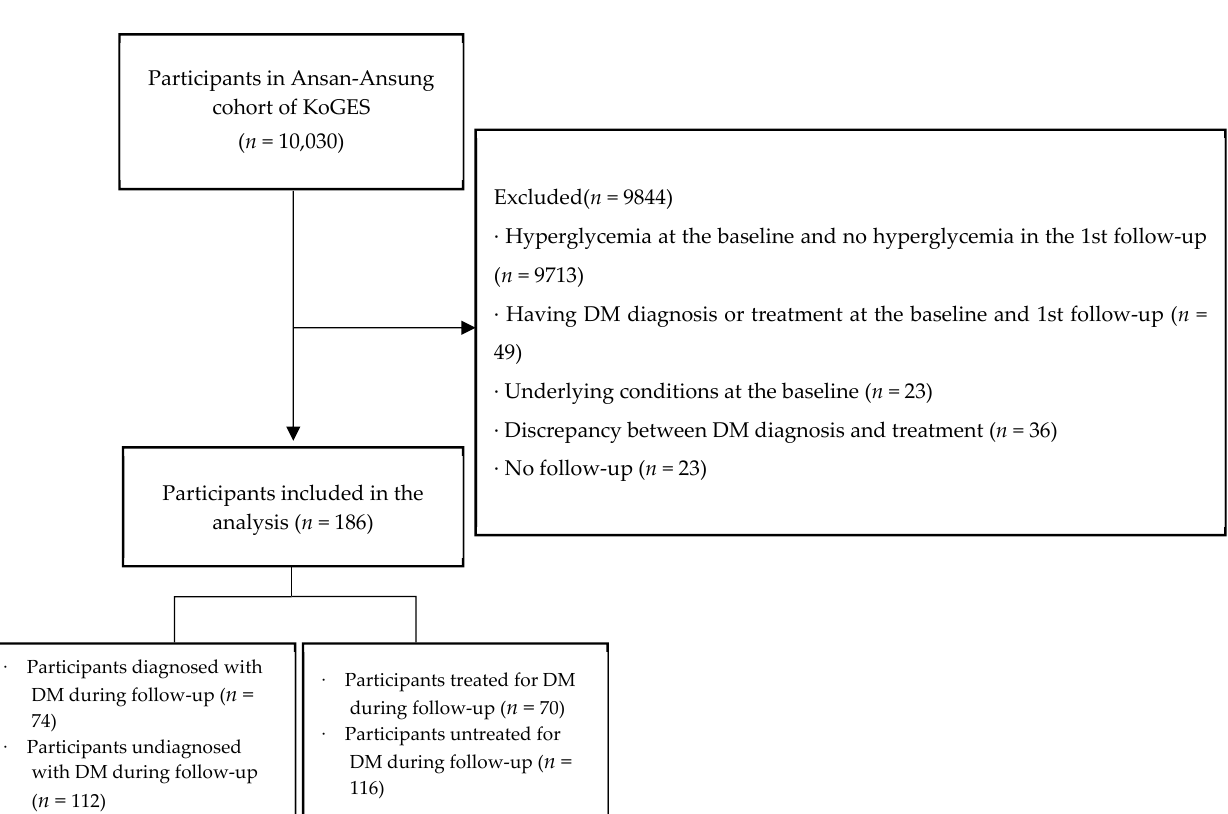
Figure 1. Flowchart of study participants’ selection. Note. DM—diabetes mellitus; KoGES—Korean Genome and Epidemiology Study.